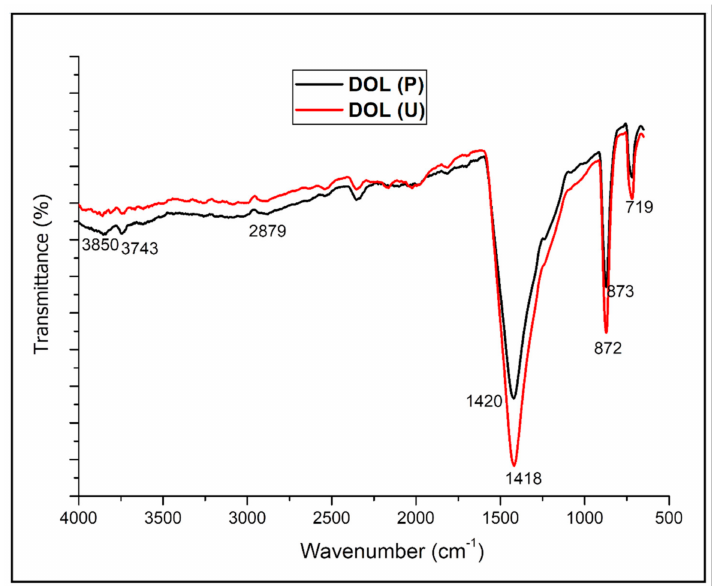
Figure 6. Fourier transform infrared spectroscopy (FTIR) spectra of pristine dolomite (DOL(P)) and sonicated dolomite